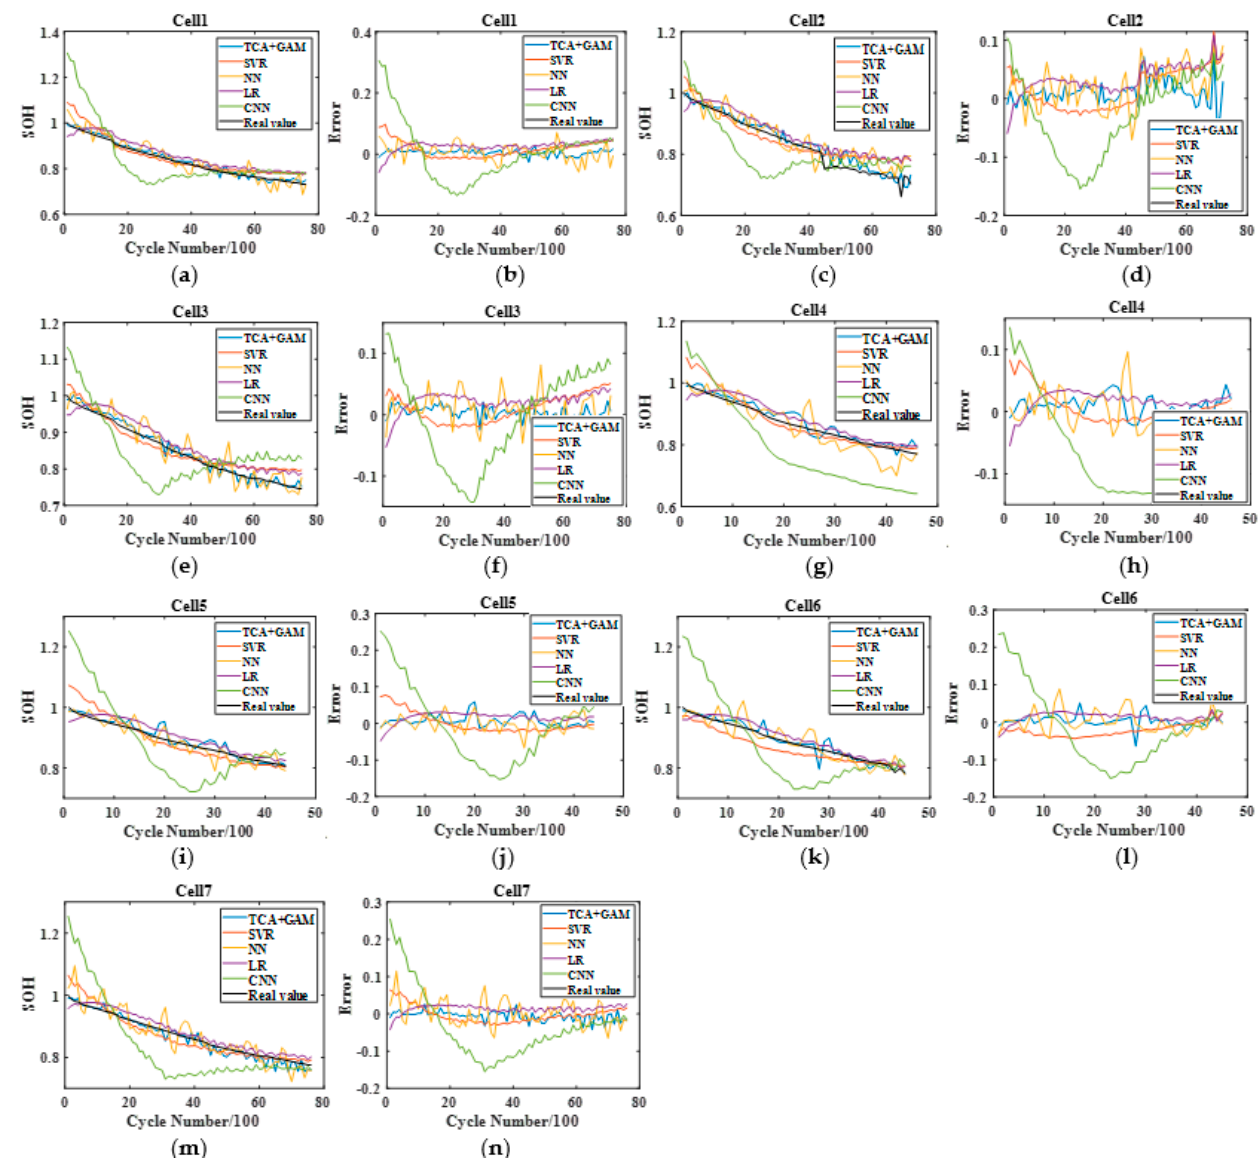
Figure 5. SOH estimation results of different models on the Oxford battery dataset: ( a , c , e , g , i , k , m ) are the SOH prediction curves of cell 1 to cell 7; ( b , d , f , h , j , l , n ) are the predicted error curves of cell 1 to cell 7. Table 2. MAE and RMSE of SOH estimation results of different models.